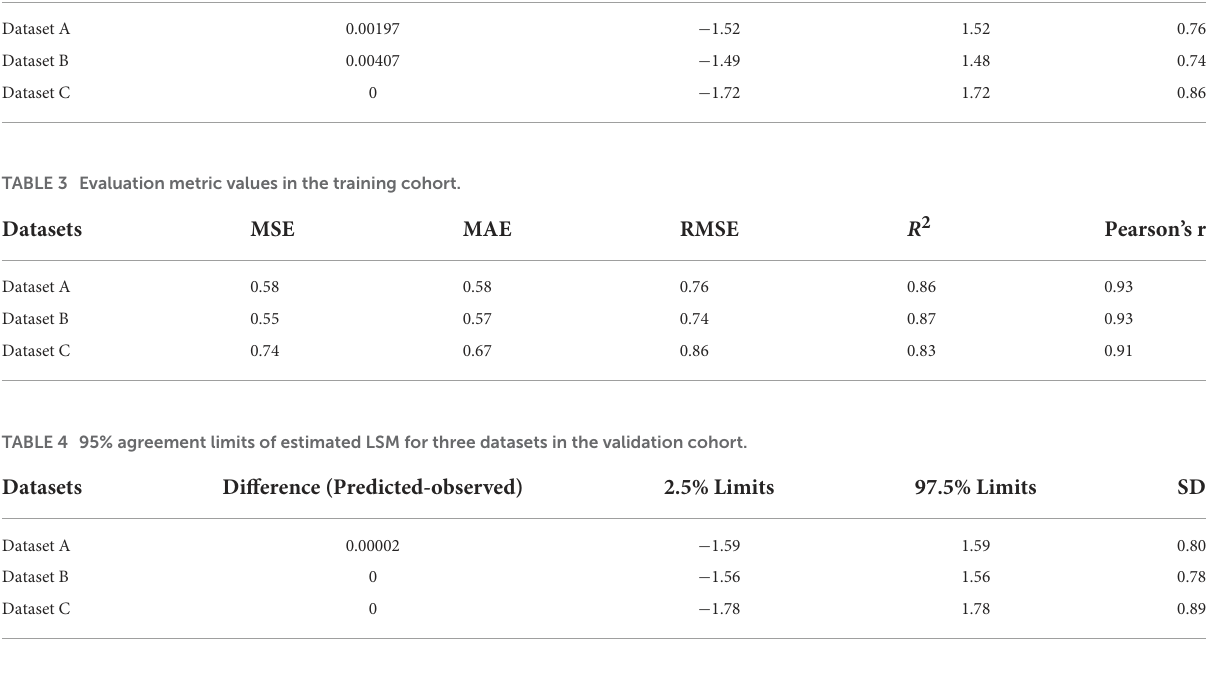
TABLE 5 Evaluation metric values in the validation